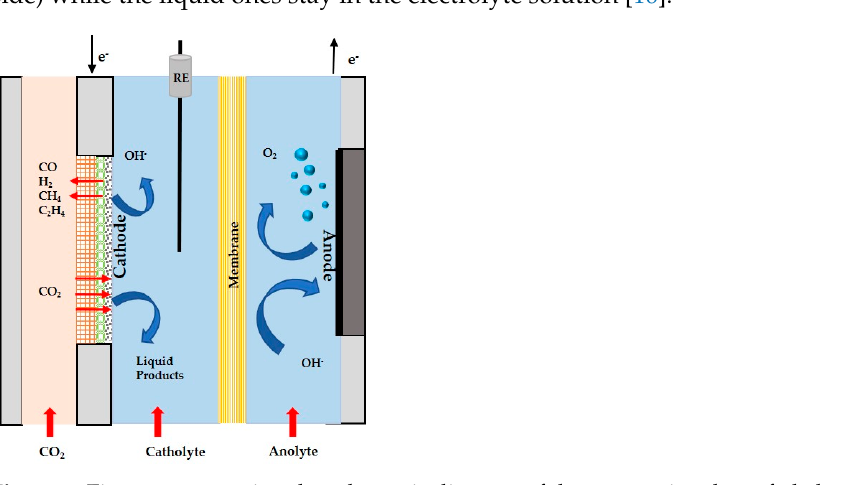
Figure 1. Figure representing the schematic diagram of the conventional gas-fed electrolyser with three different compartments. Adapted with permission from [16].